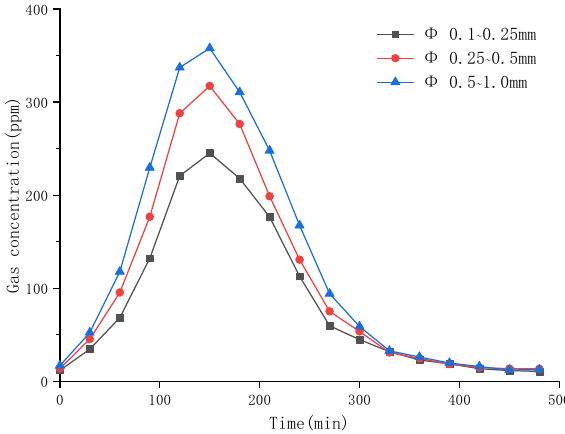
Figure 7. Adsorption effects of different particle sizes of